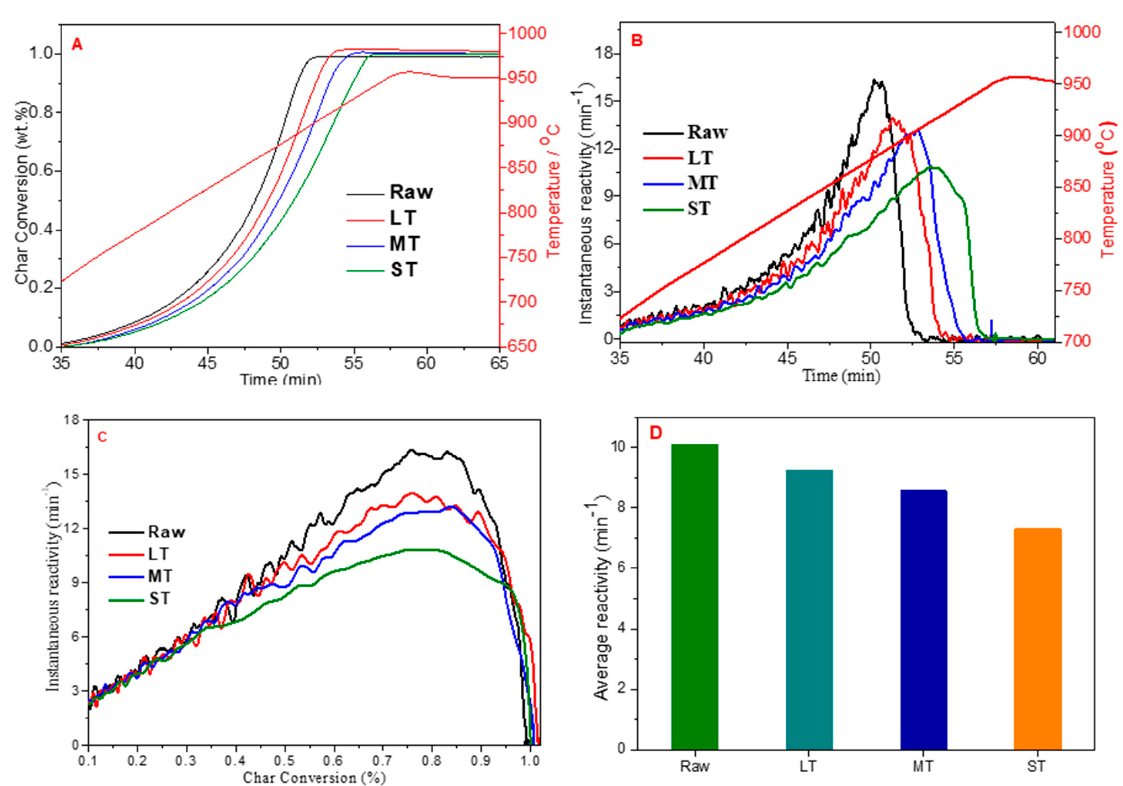
Figure 6. The effect of torrefaction severity on the carbon conversion and gasification reactivity of corncob char. ( A ) The carbon conversion, ( B , C ) instantaneous char gasification reactivity, and ( D ) average char gasification reactivity.